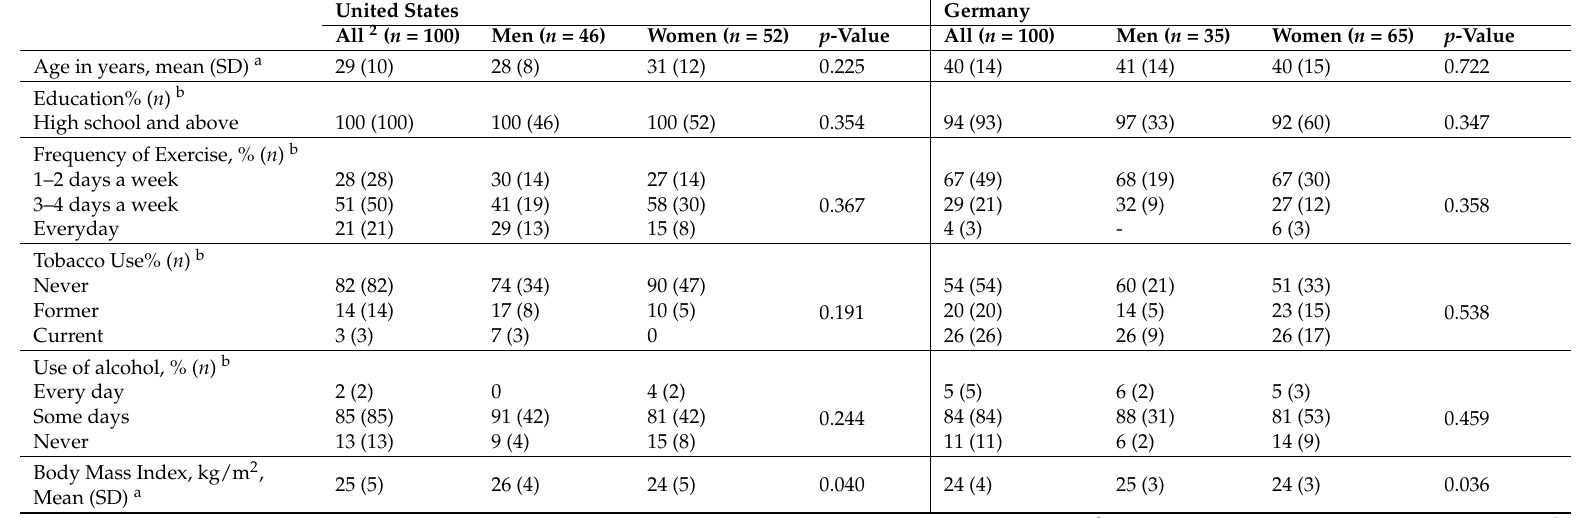
Table 1. Baseline Demographic Characteristics of Study Participants ( n = 200, aged 18–80 years) by Country and Sex 1 . United